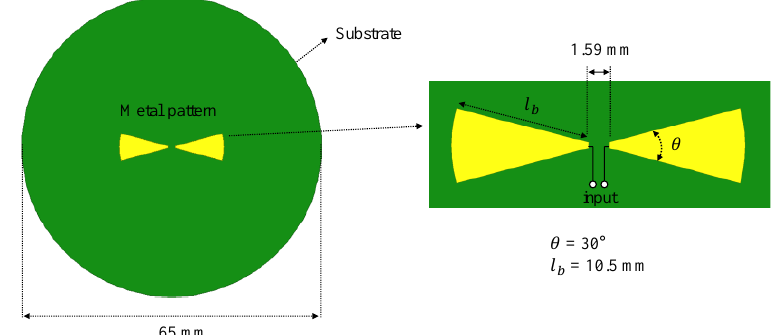
Figure 1. Designed bow-tie antenna.